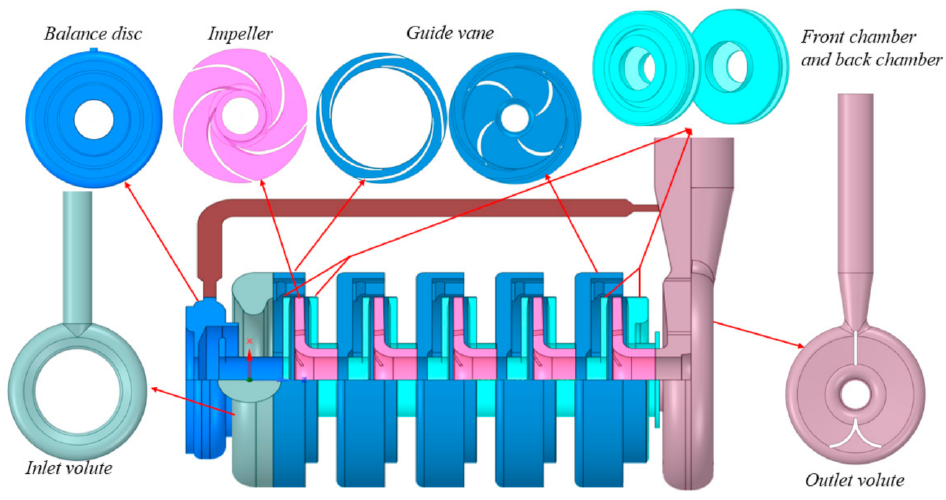
Figure 2. Multi‑stage PAT fluid model.